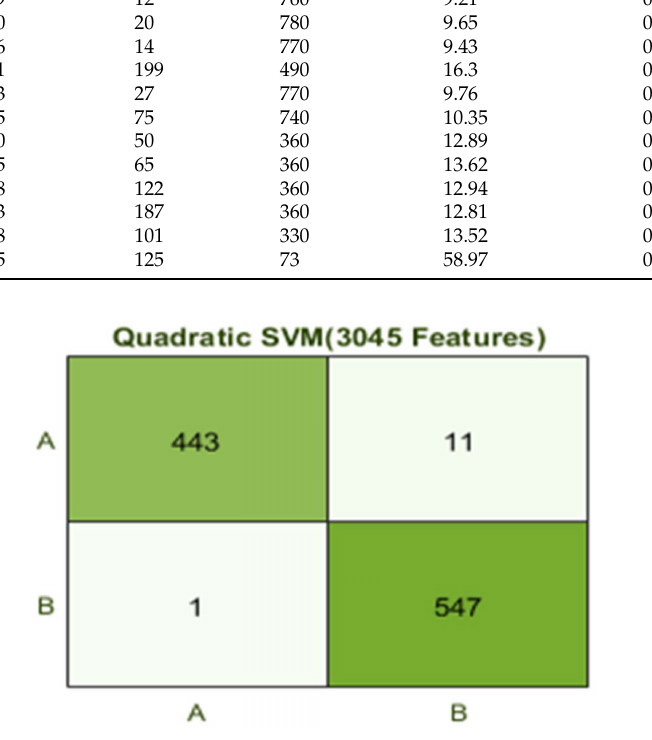
Figure 8. Confusion matrix for Q(SVM) with 3045 features and using 5-fold results.